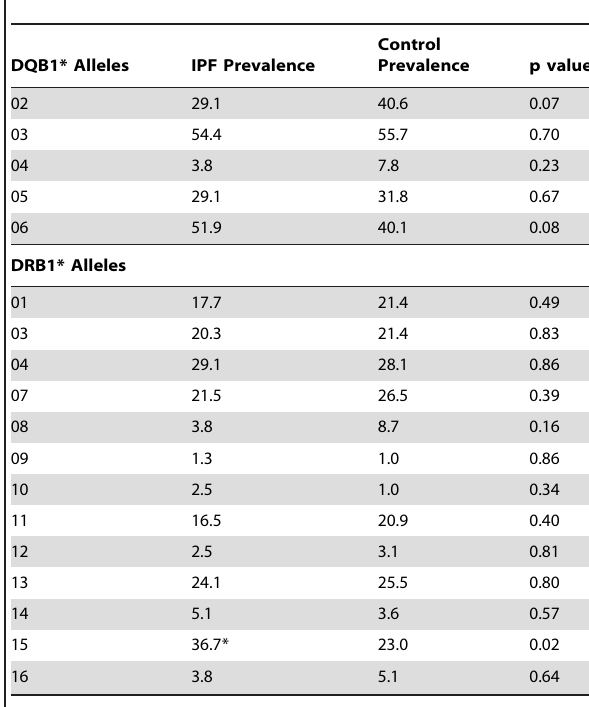
HLA allele prevalences (the percentages of subjects with one or more copies of the allele) in the initial U. Pgh. IPF transplant recipient population (n=79) were compared to those of a normal reference population (n=196). DRB1*15 was the most over-represented of the common HLA Class II alleles among the IPF (bold) relative to the controls. These initial findings prompted further study by recruitments of IPF validation cohorts from four other medical centers and high resolution typing of the DRB1*15 allele (see text).